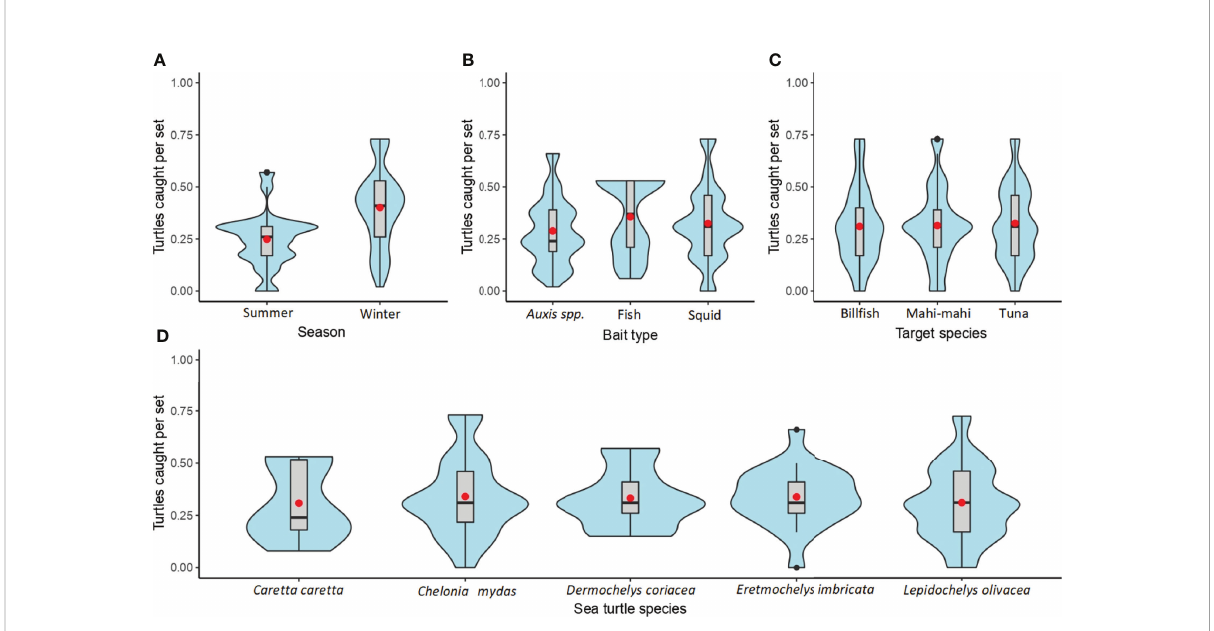
FIGURE 2 Violin plots of predicted values of the catch per unit effort according to: (A) season (B) bait type (C) target species and (D) sea turtle species, according to the observers ’ data (model 1). The thick grey bar in the center represents the interquartile range and the width of the violin represents the sample size. Red point and horizontal black line represent mean and median respectively.